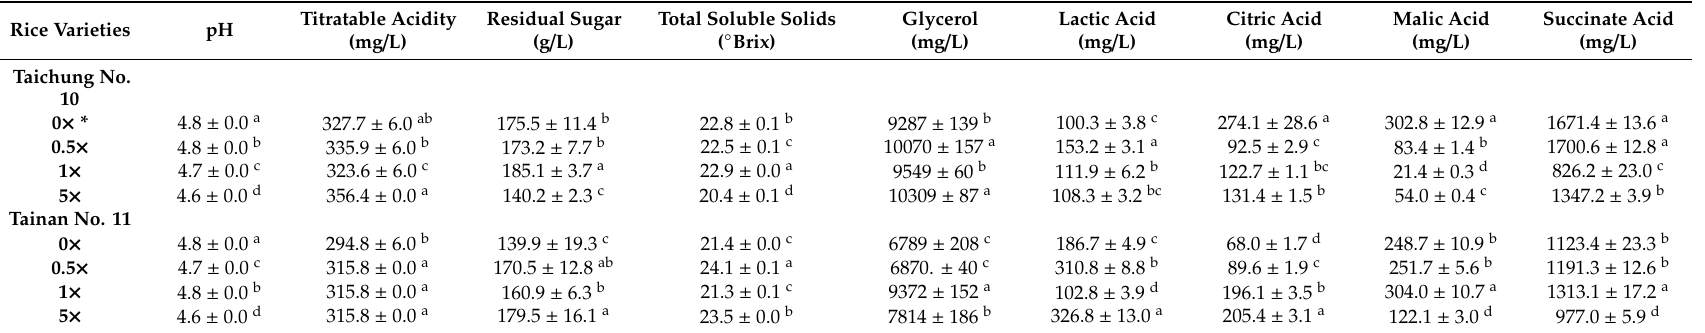
Titratable Acidity Residual Sugar Total Soluble Solids (mg / L) (g / L) ( ◦ Brix)